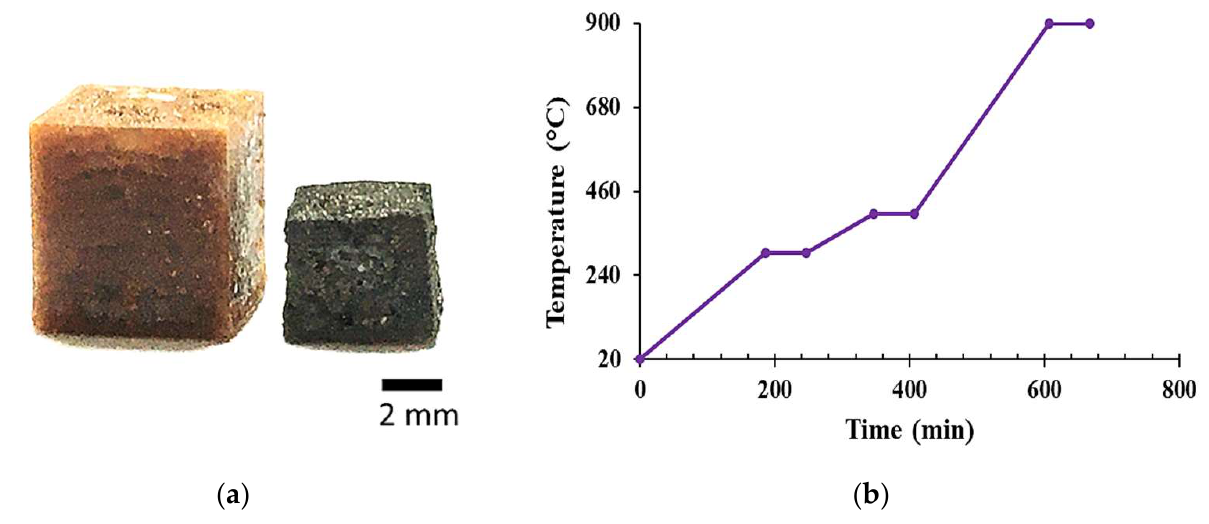
Figure 2. ( a ) Example of 3D-printed structures before ( left ) and after pyrolysis ( right ). ( b ) Heating ramp for the pyrolysis step.